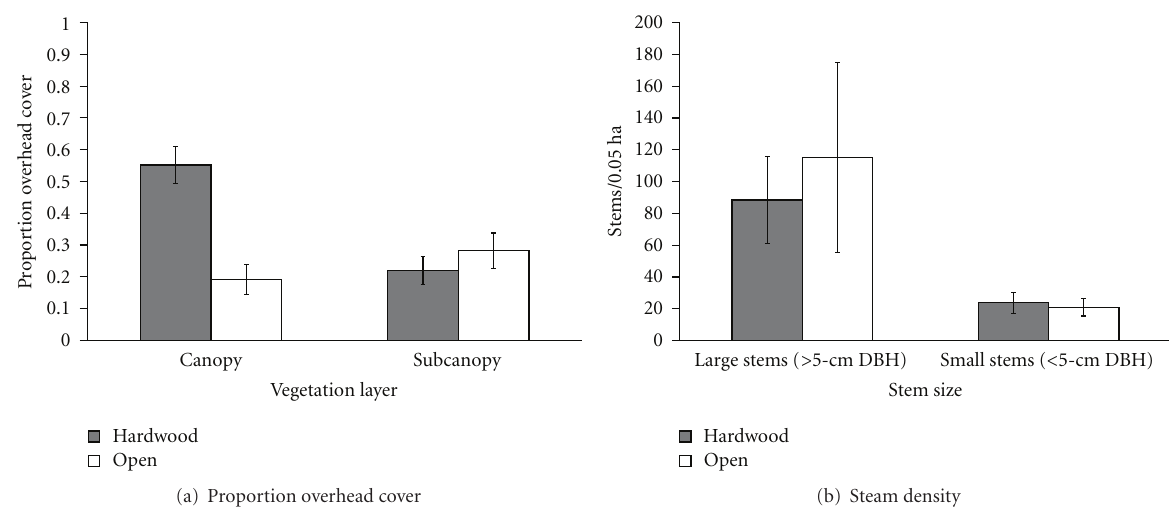
Figure 2: Mean overhead canopy cover (a) and mean stem density (b) for hardwood (gray bars) and open (white bars) cover types. Error bars represent 95% confidence